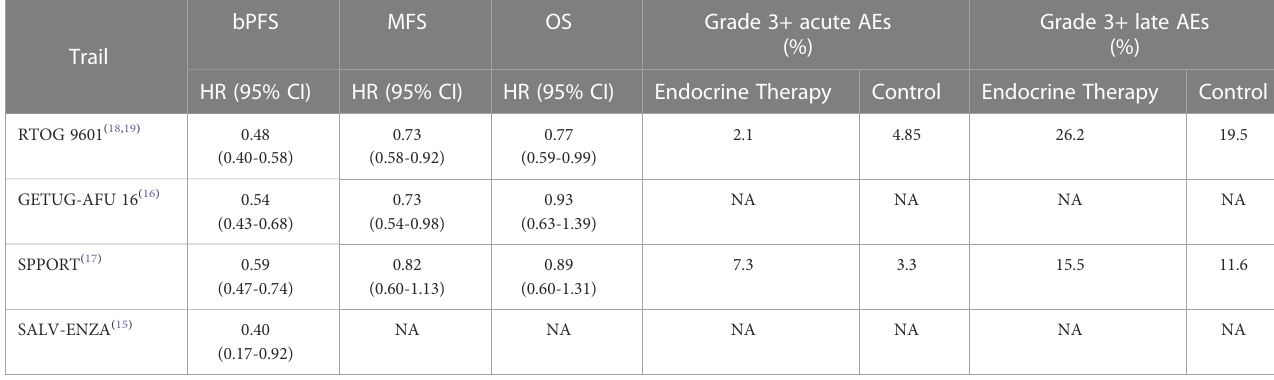
TABLE 1 Summary of ef fi cacy end points and adverse events.